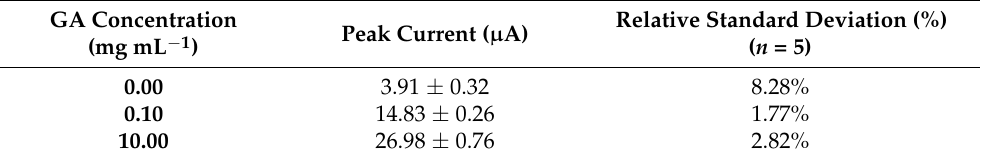
Table 2. Reproducibility of the aptasensor detection for various concentrations of GA (0, 1 and 10 mg mL − 1 ).